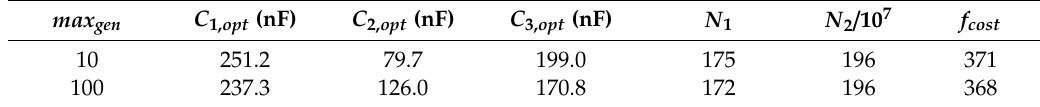
Table 3. Best solution provided by EZpp for the decaps value.